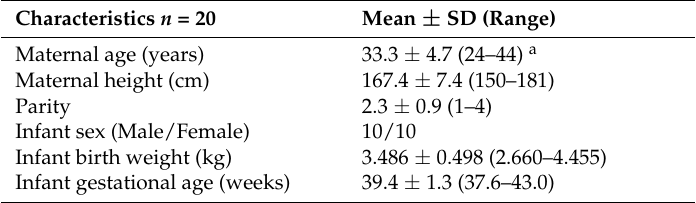
Table 2. Participant demographic characteristics at the start of the